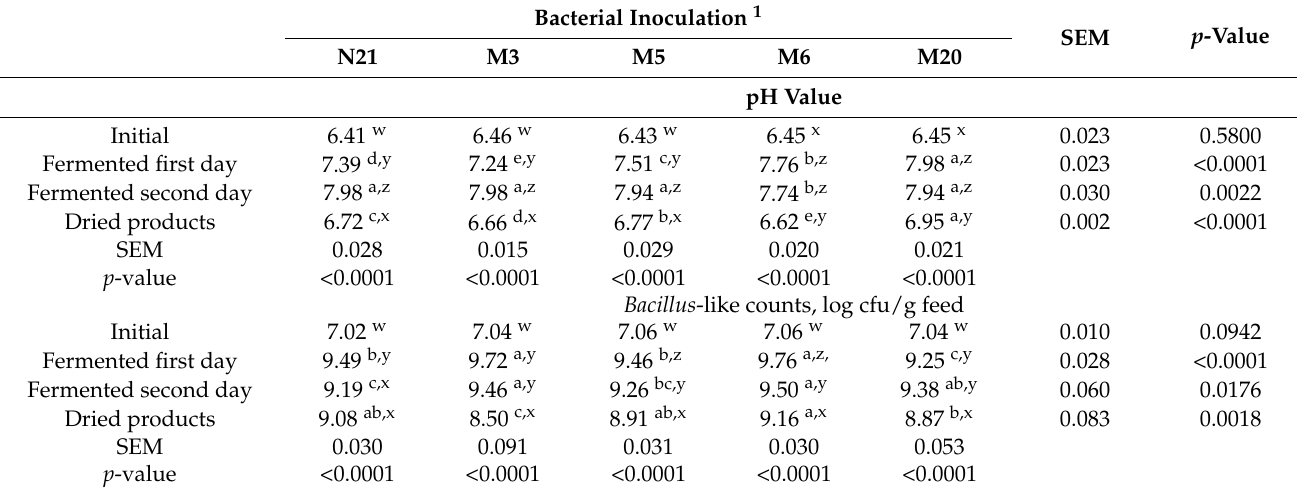
Table 4. Effects of different Bacillus strain on physiological characteristics of FMSMPs. Bacterial Inoculation